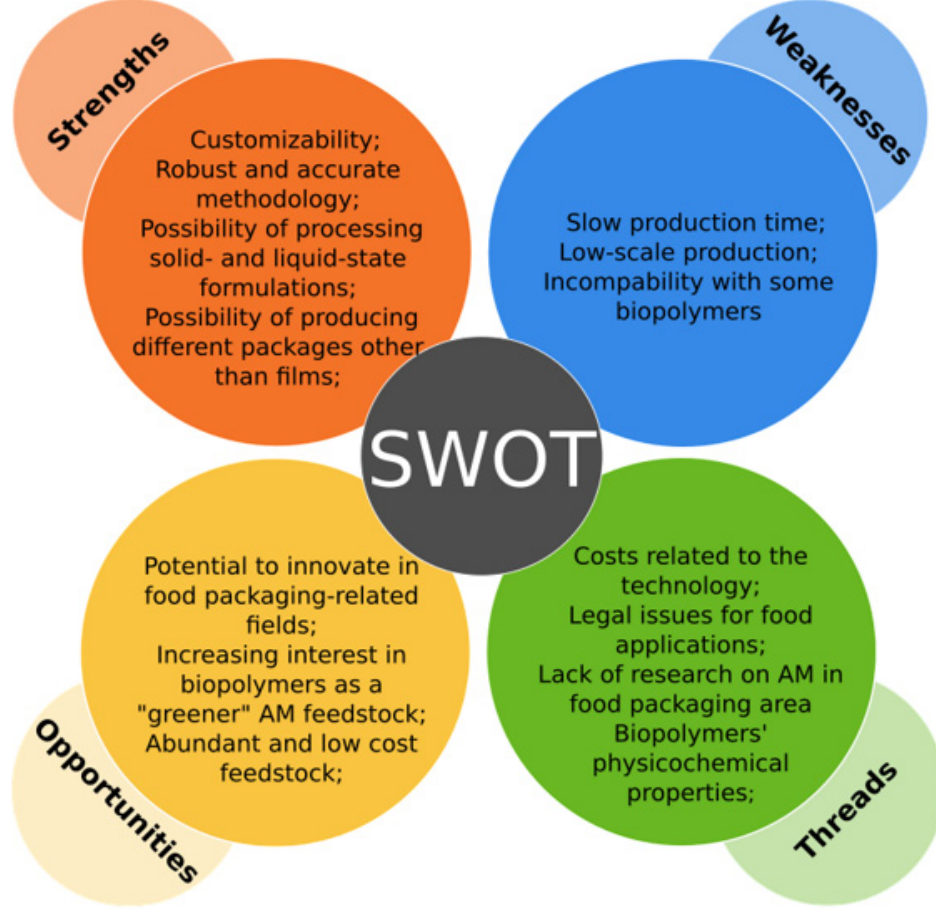
Figure 4. SWOT analysis of 3D printing as a tool for the production of bio-based films for food packaging applications.